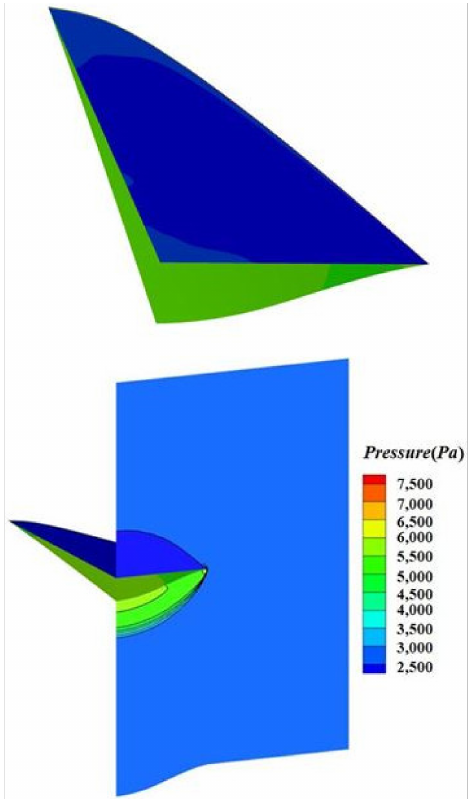
Figure 3. Pressure contour under the 0-degree angle of attack (units: Pa).